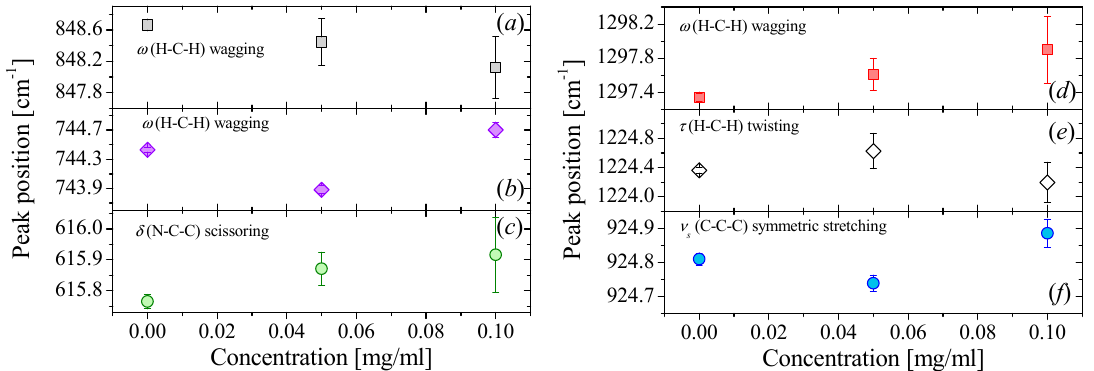
Figure 3. Raman spectra of NMP-based nanofluids for three different graphene concentrations.